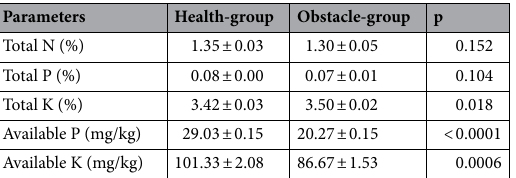
Table 1. Differences in soil chemical parameters between Health-group and Obstacle-group. Differences are analyzed using a t-test.